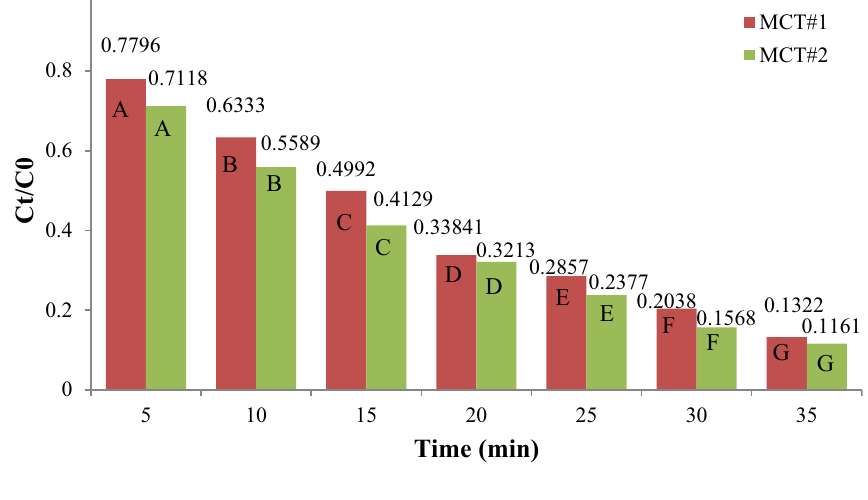
Fig. 8 Investigation of destruc- tion rate changes of MO with irradiation time (at constant pH) using MCT#1 and MCT#2 based on Duncan’s multiple range test at α =